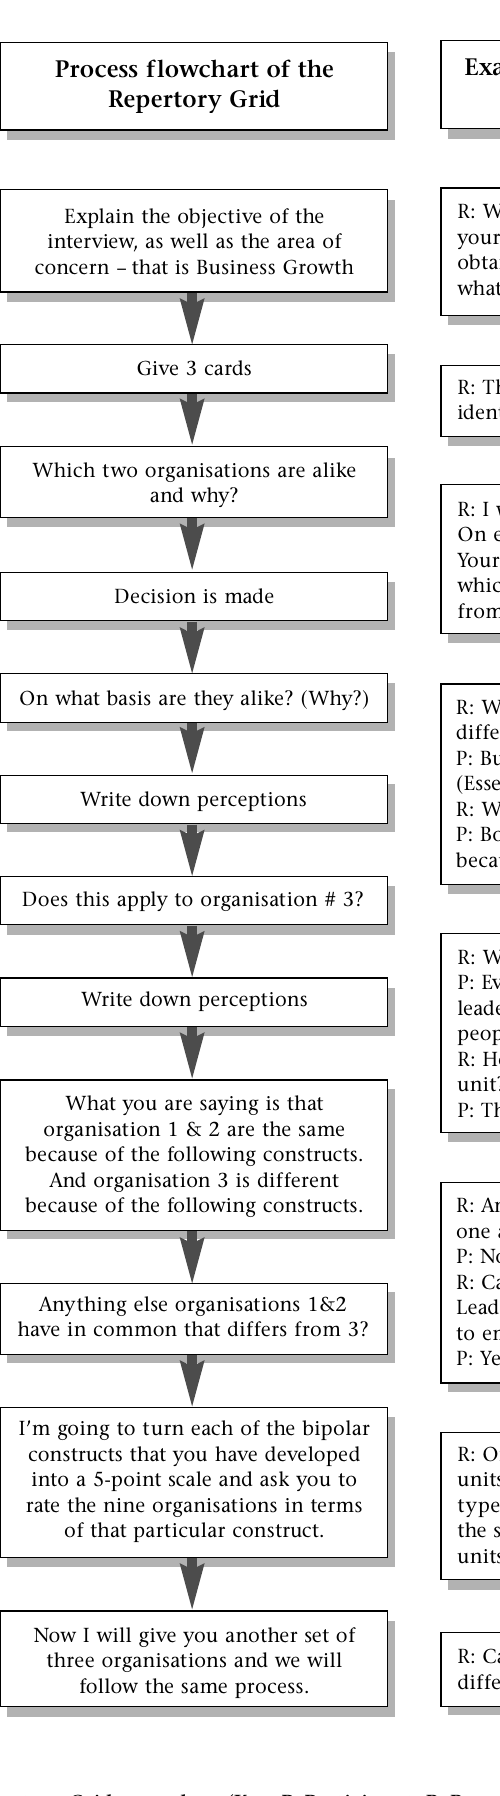
Figure 1: The Repertory Grid procedure (Key: P=Participant;